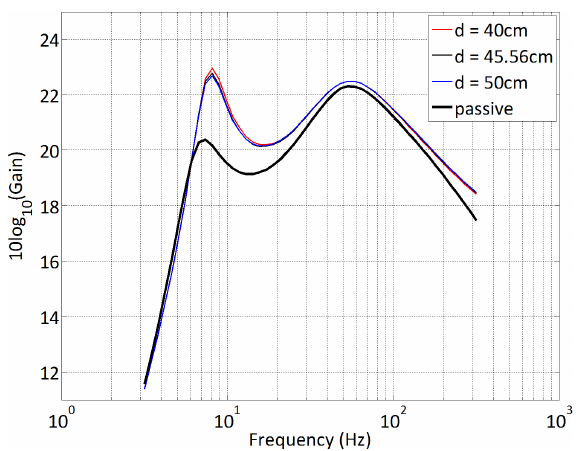
Figure 14. Frequency Domain Simulation: Car Body Acceleration.